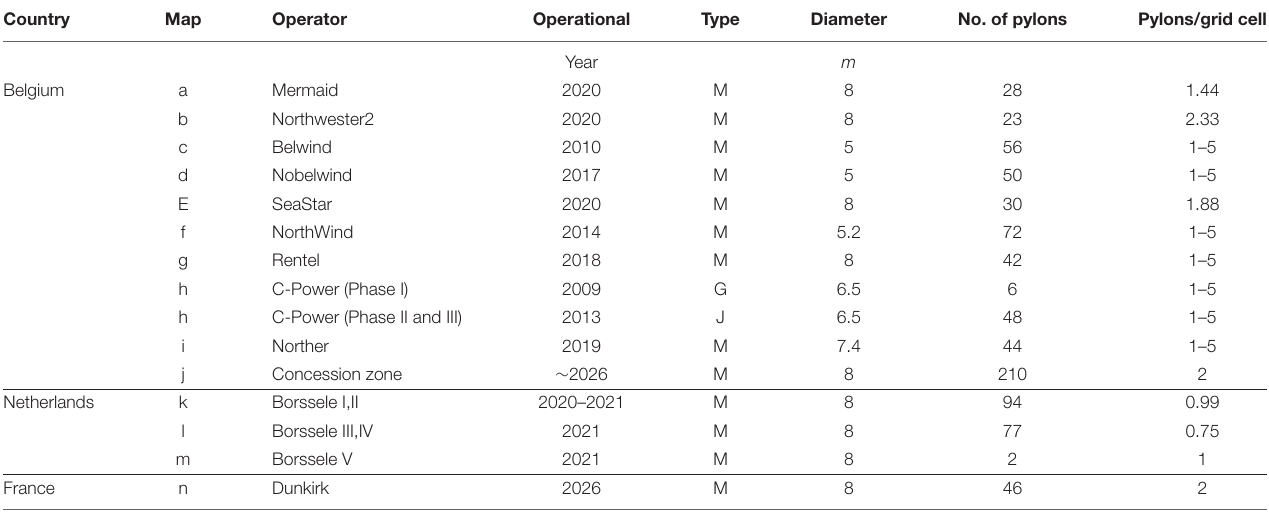
TABLE 3 | Properties of current, and future OWF zones implemented in the modeling scenarios. Country Map Operator Operational Type